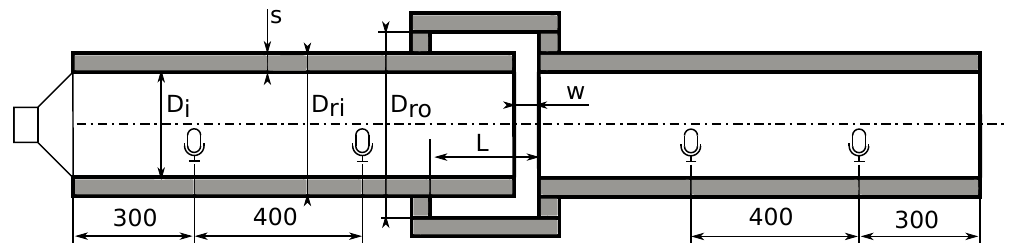
Fig. 3. Measurement apparatus schematics with positions of microphones installed in tube (dimensions are not up to scale to better illustrate geometry